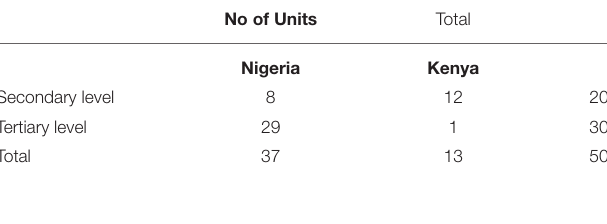
TABLE 1 | Level of neonatal care where participants worked by country.